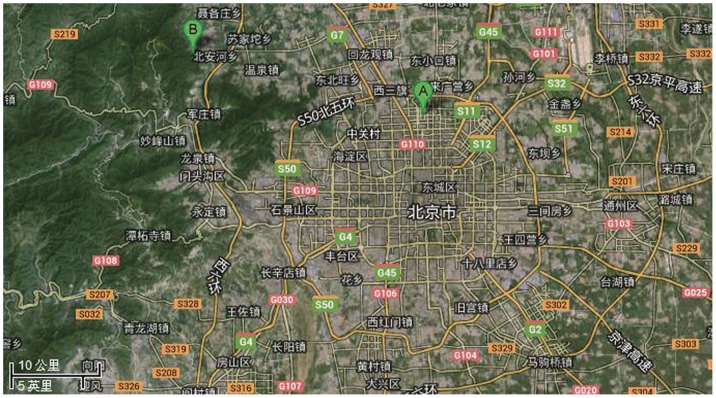
The map of the two fields.A: Olympic Forest Park in Beijing. B: Jiufeng National Forest Park in Beijing.